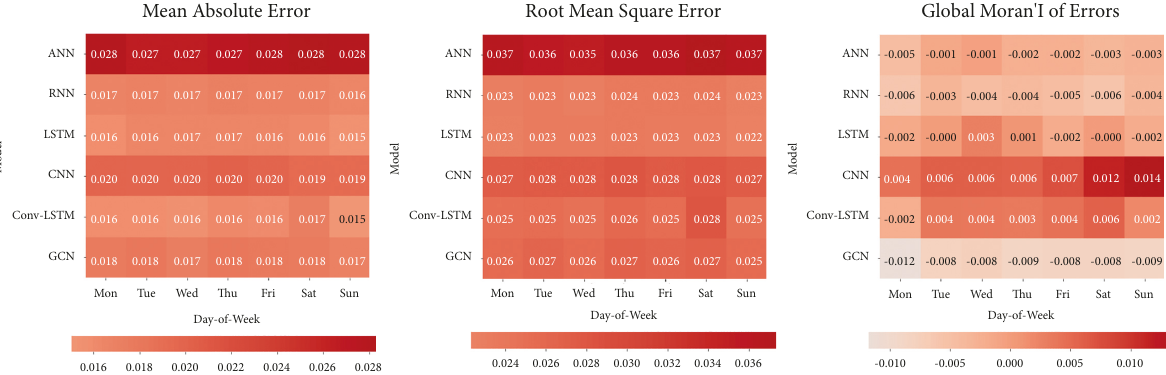
Figure 4: Performance metrics and global Moran’s I of error for